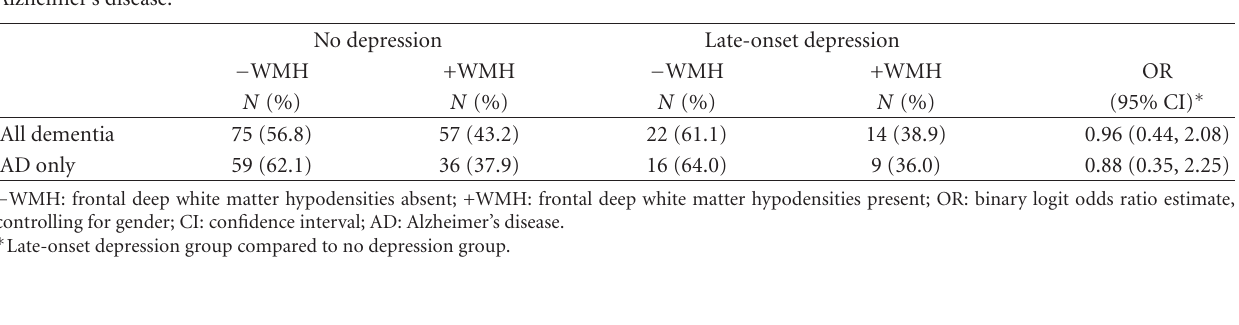
Table 4: risk of frontal lobe deep white matter hypodensities in late-onset depression compared with no depression for all dementia and Alzheimer’s disease.